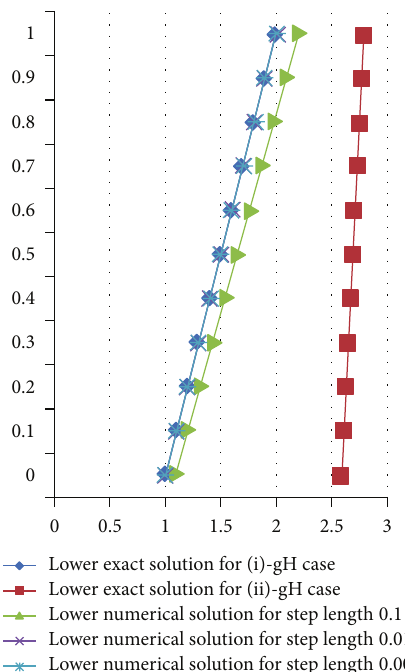
Figure 3: Comparison of lower exact solutions and numerical solution for different step lengths at 𝑡 = 0.4